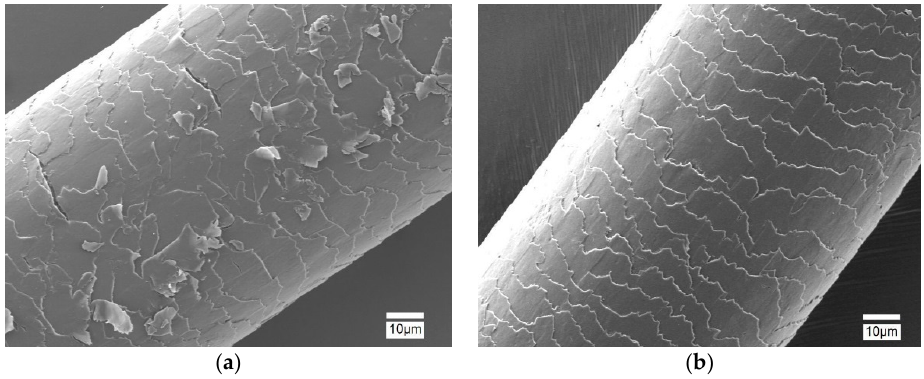
Figure 5. Cuticle morphology of ( a ) unprotected virgin hair after six exposure cycles and ( b ) unexposed virgin hair.